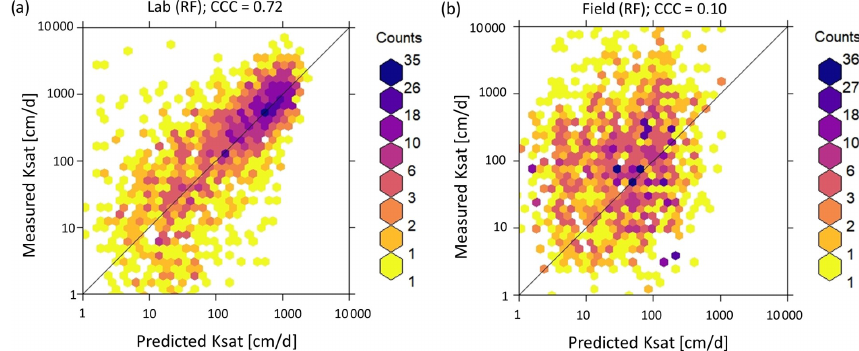
Figure 5. The correlation between observed and predicted K sat values obtained from random forest (RF) models. The RF-based pedotransfer function (PTF) model was fitted using data for laboratory measurements of K sat and tested on both laboratory (a) and field (b) measure- ments. Results showed reasonable agreement (CCC = 0.72) using RF algorithms for laboratory measurements, but low CCC (0.10) for field measurements. PTFs developed based on laboratory measurements do not provide accurate estimates of K sat measured in the